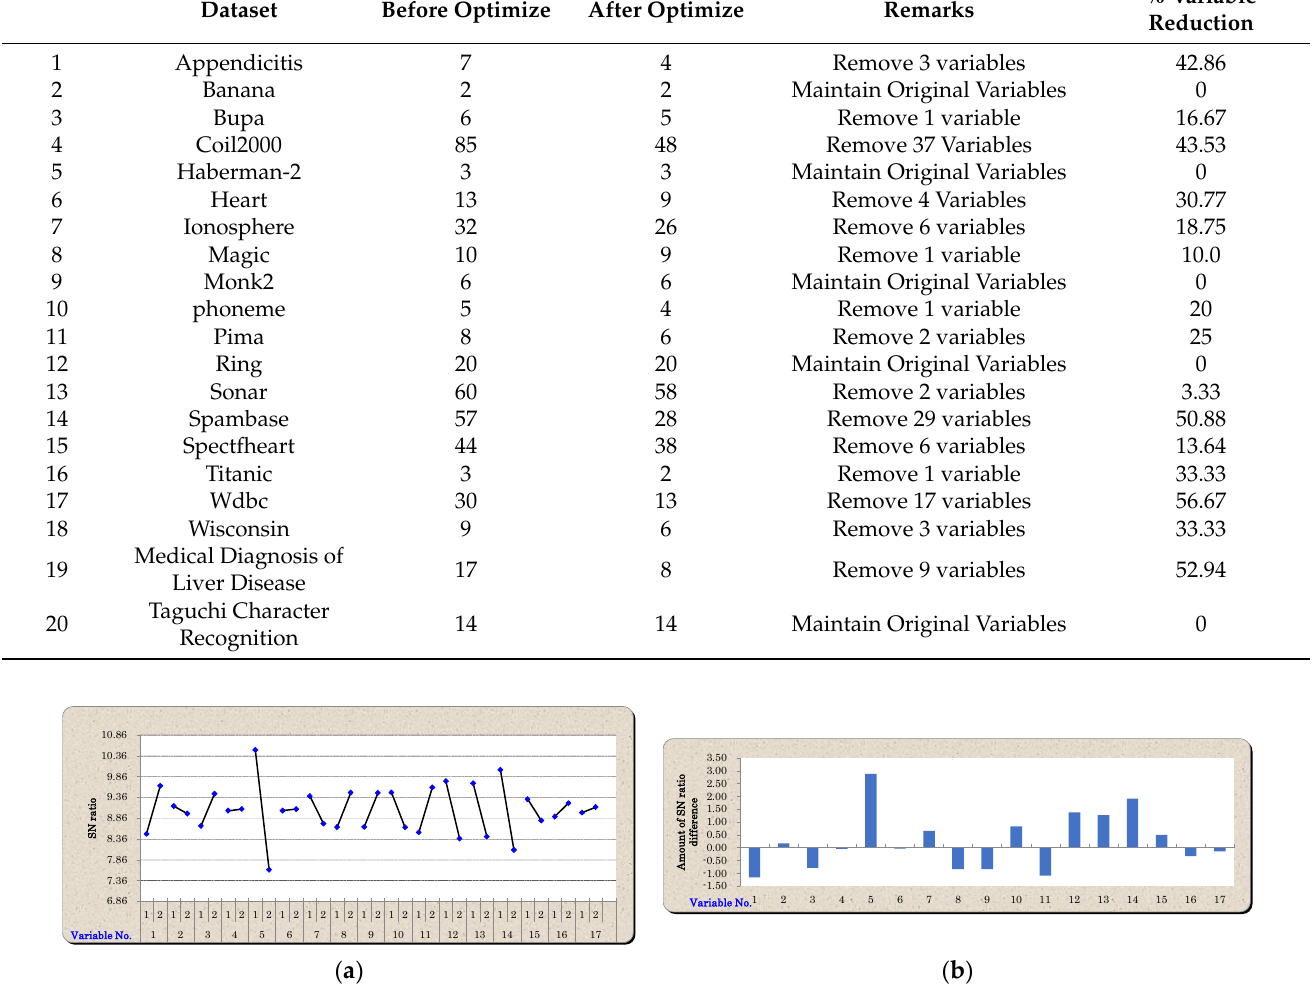
Table 7. Reduction in the number of variables optimized via MTS.